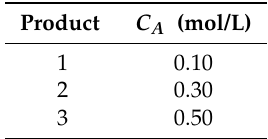
Table 1. Product specifications.